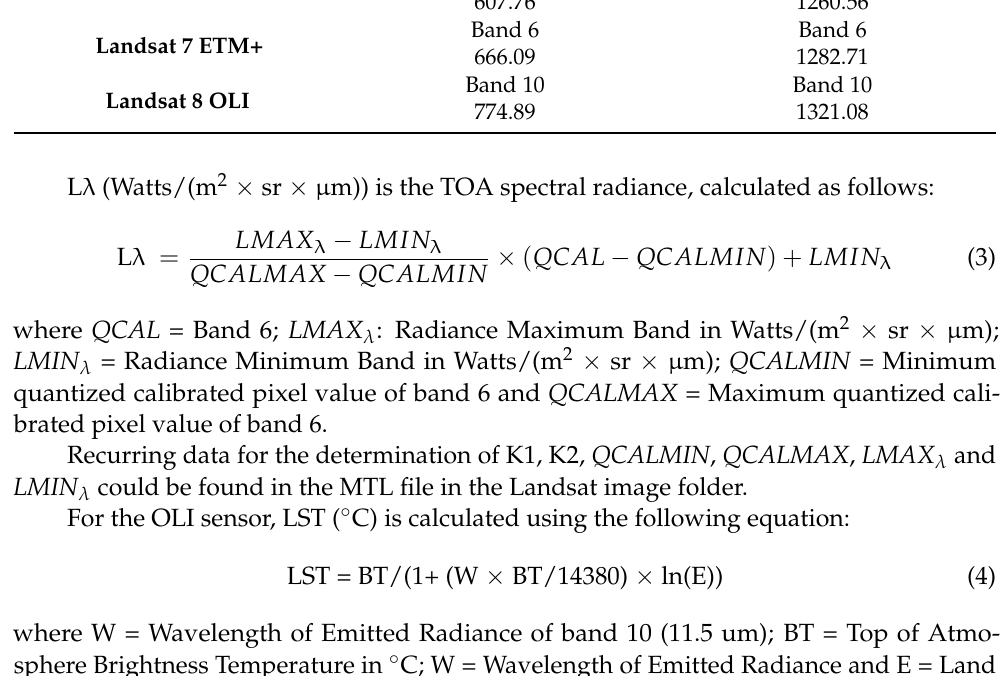
Table 3. Values of K1 and K2 for Landsat 5 (TM), Landsat 7 (ETM+) and Landsat 8 (OLI). Sensor K1 K2 Landsat 5